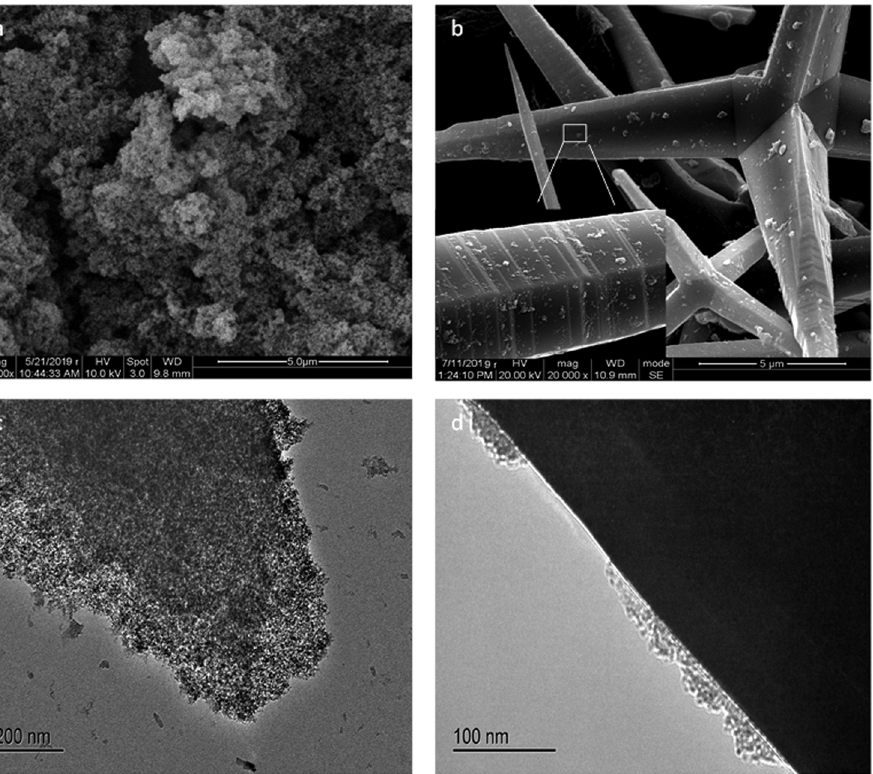
Figure 1: Morphologies of SiO 2 ( AG ) and SiO 2 ( AG ) /T - ZnO samples. ( a ) SEM image of SiO 2 ( AG ) ; ( b ) SEM image of SiO 2 ( AG ) /T - ZnO; ( c ) TEM image of SiO 2 ( AG ) ; and ( d ) TEM image of SiO 2 ( AG ) /T - ZnO.